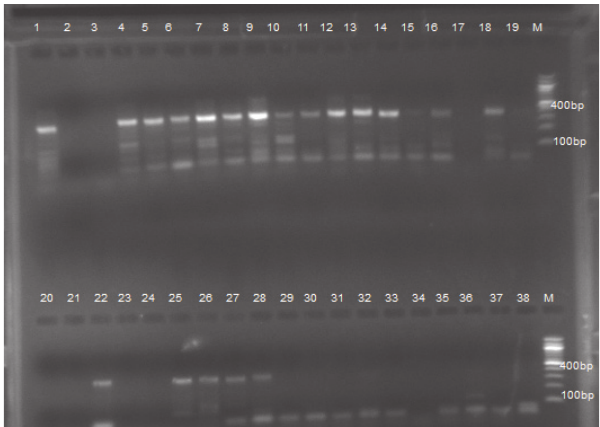
Figure 3: Agarose gel (1.5%) electrophoresis of amplified DNA from Babesia. Lane M: DNA ladder (100bp). Lane 1: positive control and Lane 20: negative control. Positive product showed clear band in